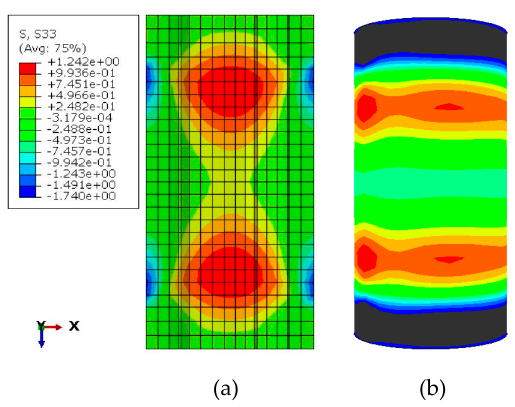
Figure 10. Stress distribution in the FEM: ( a ) Longitudinal section; ( b ) Volumetric view.